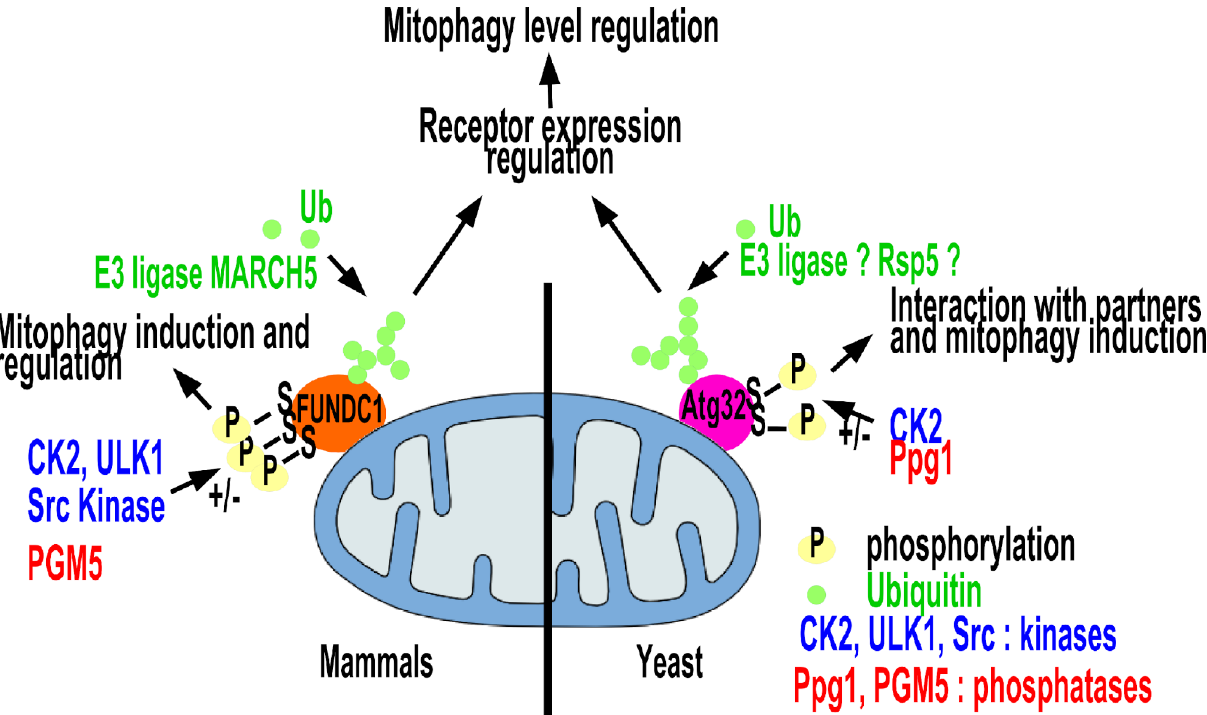
Figure 3. Regulation of receptor-involved mitophagy in yeast and mammals. Following the mitophagy induction, both yeast Atg32 and mammalian FUNDC1 receptors undergo the same type of post-translational modifications. Phosphorylation of mitophagic receptors plays a pivotal role in either promoting or inhibiting mitophagy depending on the circumstances. In reaction to hypoxia or depolarization of mitochondrial membrane potential, the mitochondrial phosphatase PGAM5 interacts with FUNDC1 and dephosphorylates the serine 13 residue. This enhances its interaction with LC3, which ultimately leads to mitophagy induction. The kinase CK2 phosphorylates FUNDC1 to reverse the effect of PGAM5 in mitophagy induction. In addition, the mitochondrial E3 ligase MARCH5 plays a role in regulating hypoxia-induced mitophagy by ubiquitinilating FUNDC1 and causing its degradation to limit excessive mitochondrial degradation. In yeast, during nitrogen starvation or in stationary phase, CK2 kinase phosphorylates Atg32 protein on serines 114 and 119; these modifications are essential for the initiation of mitophagy. Ubiquitination is also involved in regulation of Atg32 activity.